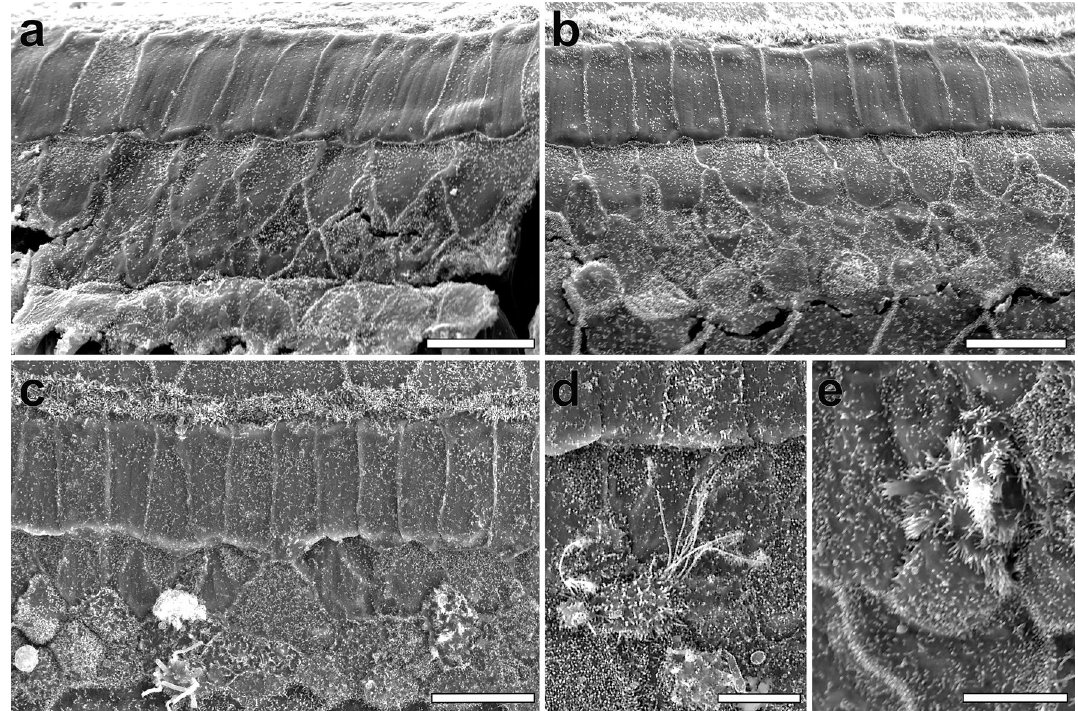
Figure 5. SEM of the organ of Corti in control and Ad. Gfi1.Atoh1 treated ears. SEM images taken 8 weeks after Ad. Gfi1.Atoh1 surgery and DT injection in control (contralateral) ear ( a ) or experimental ears ( b – e ). Contralateral ear showed no remaining inner and outer hair cell stereocilia. Microvilli on surface delineate rhomboidal shaped cell borders of Deiters cells in the reorganized reticular lamina ( a ). Ad. Gfi1.Atoh1 injected ear exhibits several round shaped cells bulging from the surface of the reticular lamina and displaying microvilli resembling stereocilia, in a cauliflower appearance ( b ). Some cells are displaying multiple thick kinocilia-like projections arranged in bundles ( c ). Cells with stereocilia throughout the surface with multiple long kinocilia ( d ). Some cells had stereocilia in a clustered form ( e ). Representative images from 3 biological replicates. Scale bar = 10 μm for ( a – c ), 5 μm for ( d , e ).